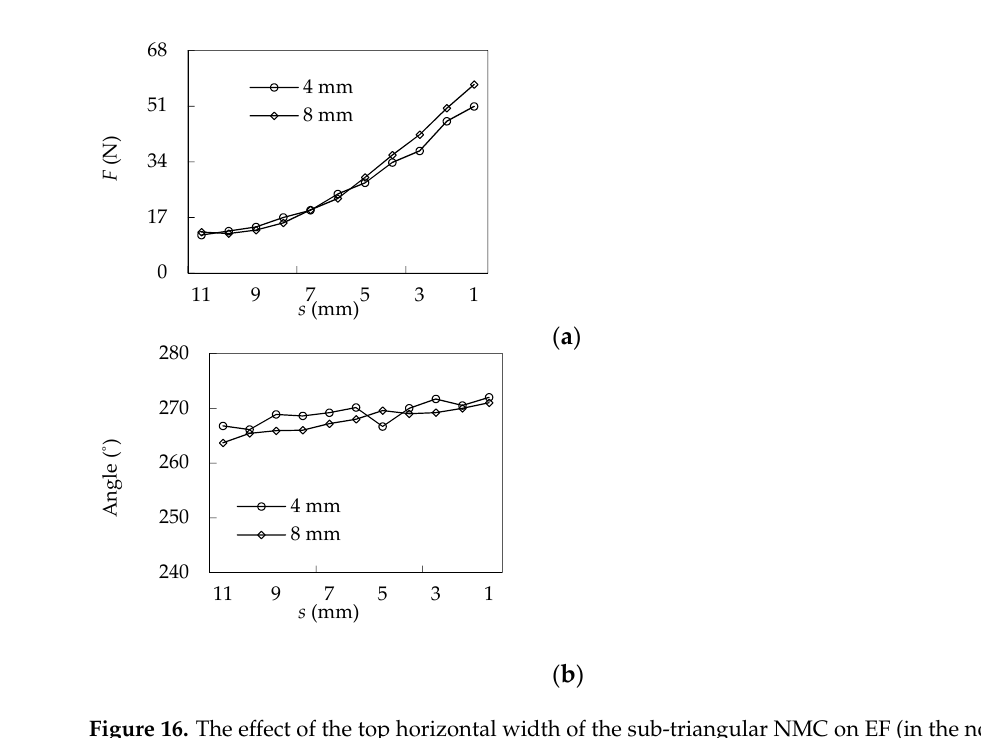
Figure 17. The effect of the bottom size of the sub-triangular NMC on EF: ( a ) the amplitude curve; ( b ) the phase curve.